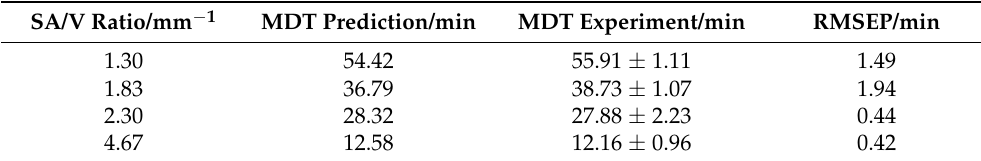
Table 6. Comparison of MDT: predicted vs. experimental data of the PVA-PZQ formulation ( n ≥ 3; x ±